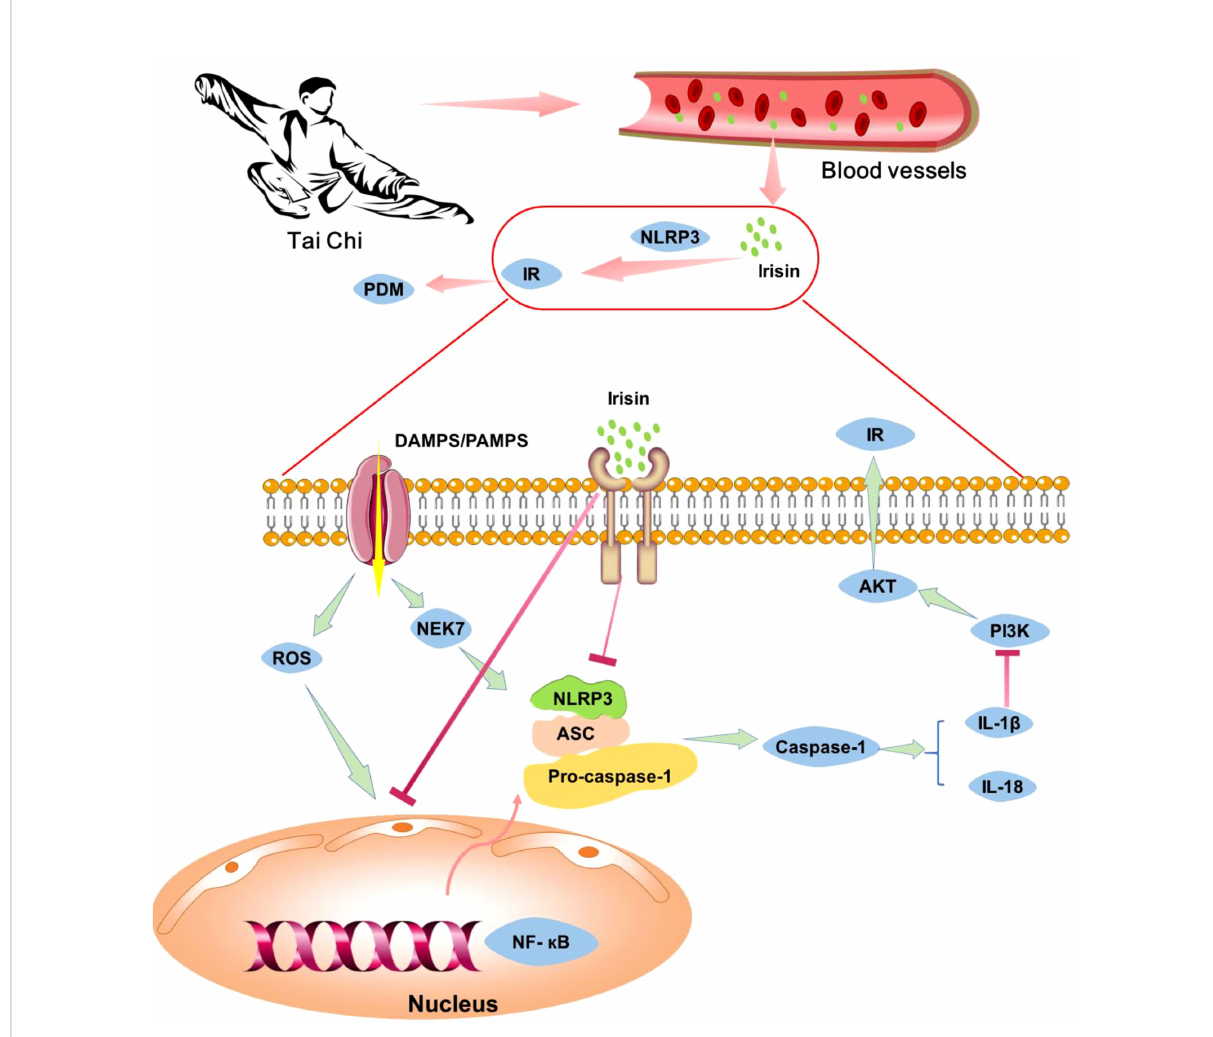
FIGURE 2 The potential mechanism of Tai Chi intervention relieves pre-diabetes by inhibiting in fl ammation cytokines. Tai Chi intervention can increase the level of irisin in the blood, thus inhibiting the expression of NLRP3 in fl ammasome and other in fl ammatory factors, enhancing insulin receptor sensitivity, relieving insulin resistance and